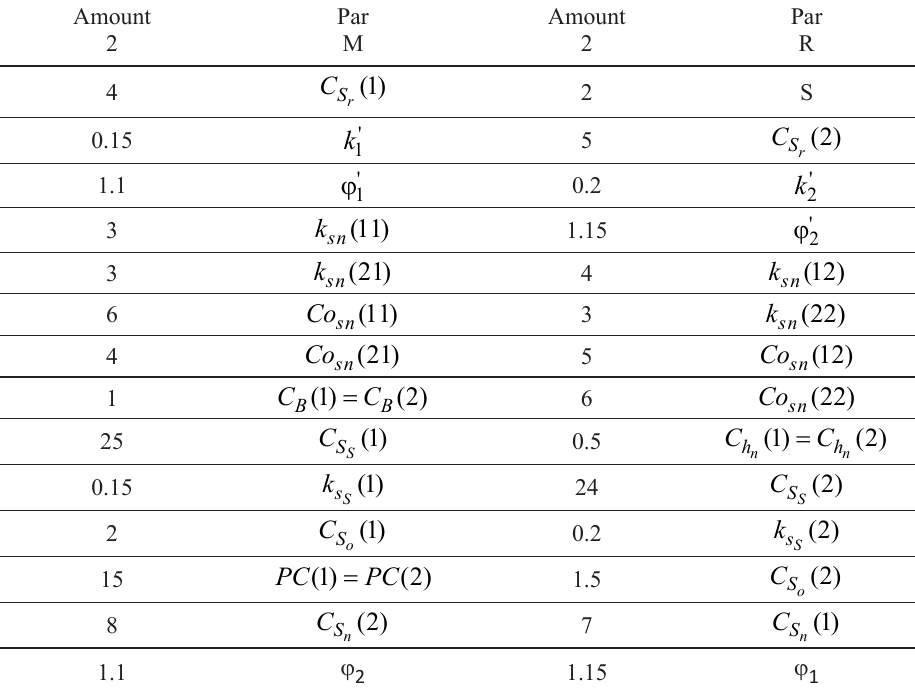
Table 4. Initial data on the numerical